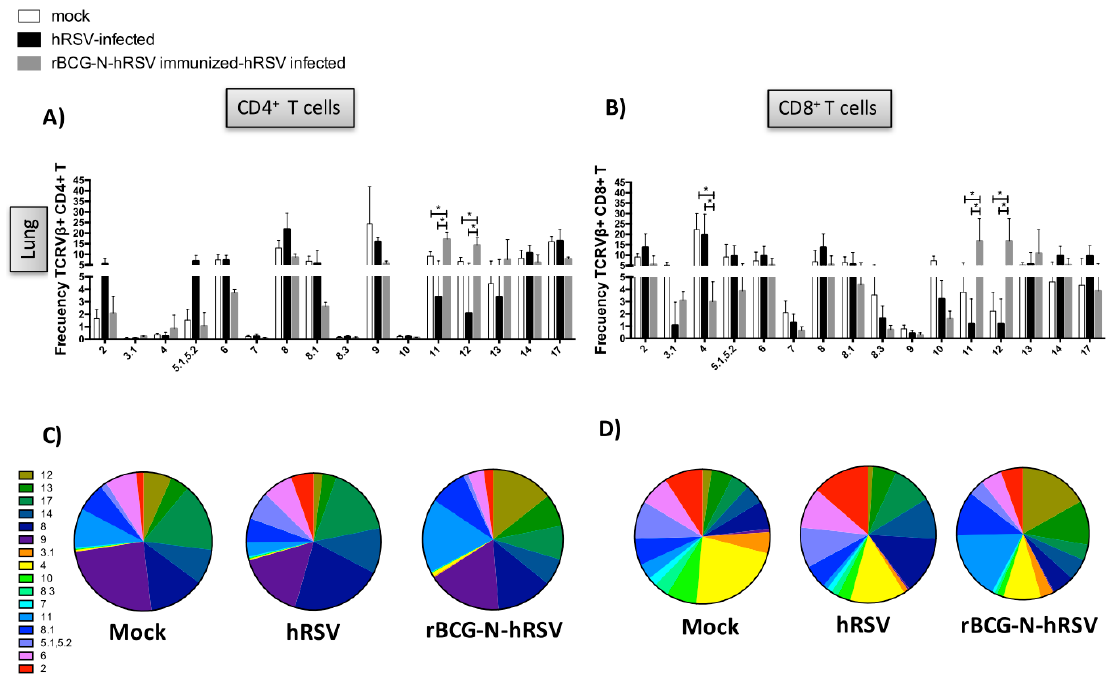
Figure 5. TCRV β + expression in the CD4 + and CD8 + T cells in the lungs in the context of infection and immunization. BALB / cJ mice were immunized with rBCG-N-hRSV and 14 days postimmunization were infected with 1 × 10 6 PFU of hRSV. Four days after infection, mice were euthanized. The expression of di ff erent TCRV β + in CD4 + and CD8 + T cells was evaluated by flow cytometry in lungs extracted from rBCG-N-hRSV immunized and hRSV-infected mice. Frequencies are shown in bars ( A , C ) and in pie charts ( B , D ). The di ff erences between TCRV β + expression among the di ff erent experimental groups were determined using multiple t -students tests, * p < 0.05. Bars represent mean ± SD in all graphs.